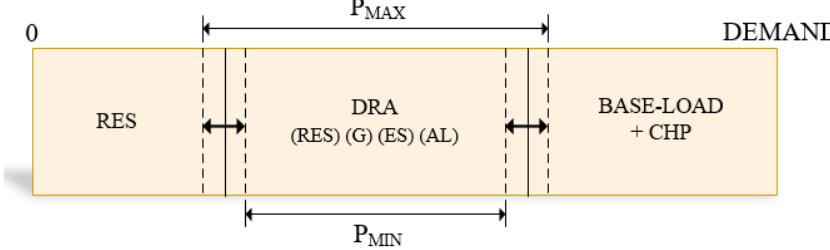
Figure 5. The proposed position of the DRA operation in the power system.